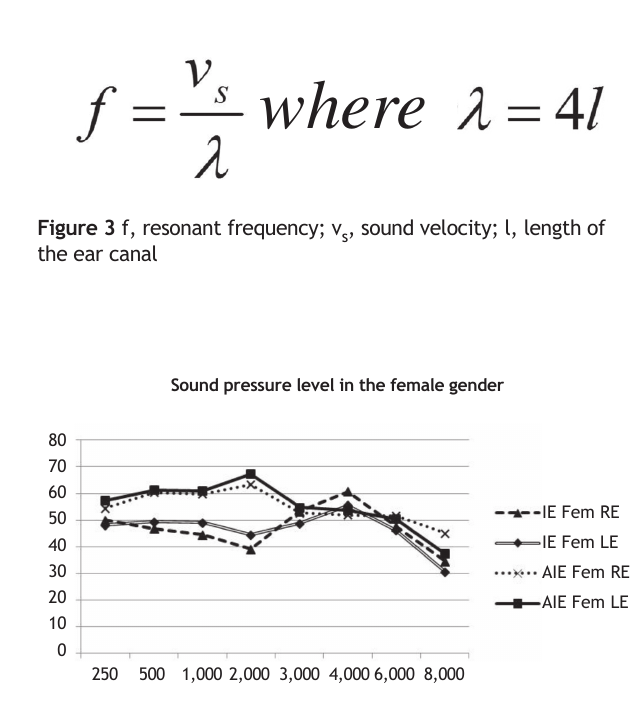
Figure 4 Sound pressure level with the two types of earphones and in both ears in female